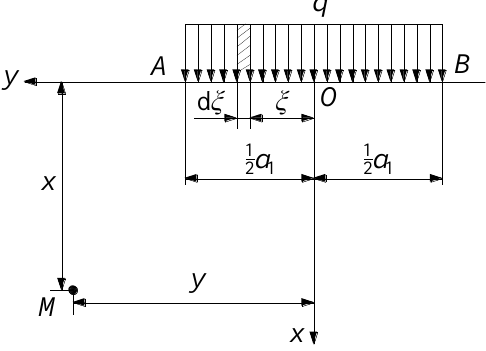
Figure 18. Mechanical model of stress under the upper pillar.